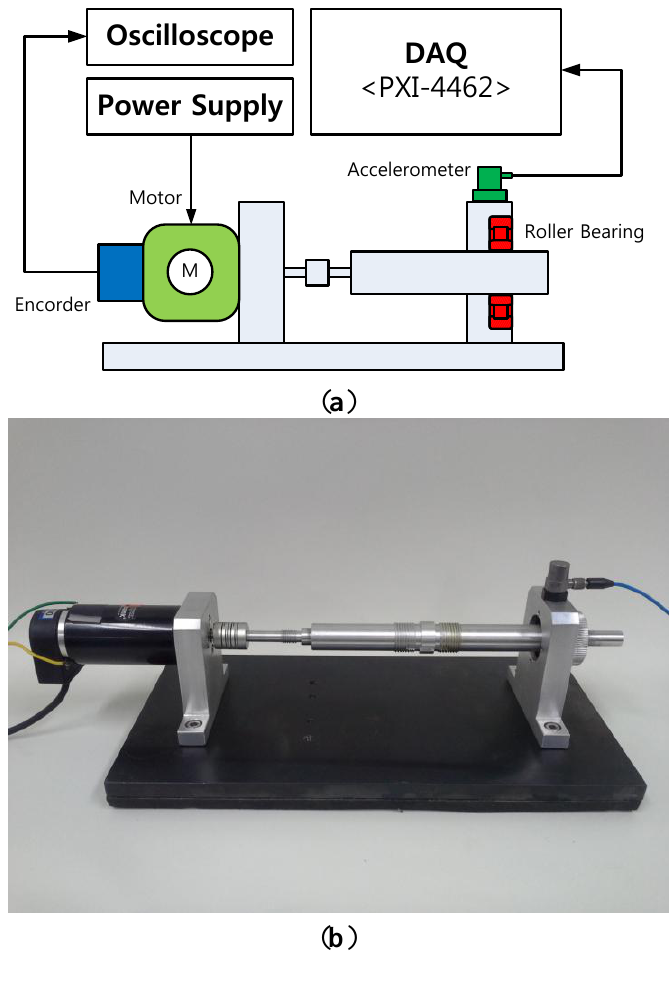
Figure 4. ( a ) Schematic configuration of a bearing test bench and ( b ) the experimental